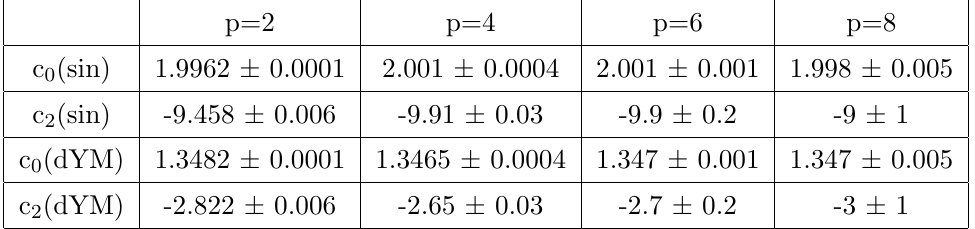
Table 4 . c 0 and c 2 for even power polynomial (cid:12)ts of order p for T 2 = T 1 for noised ( law data and dYM.